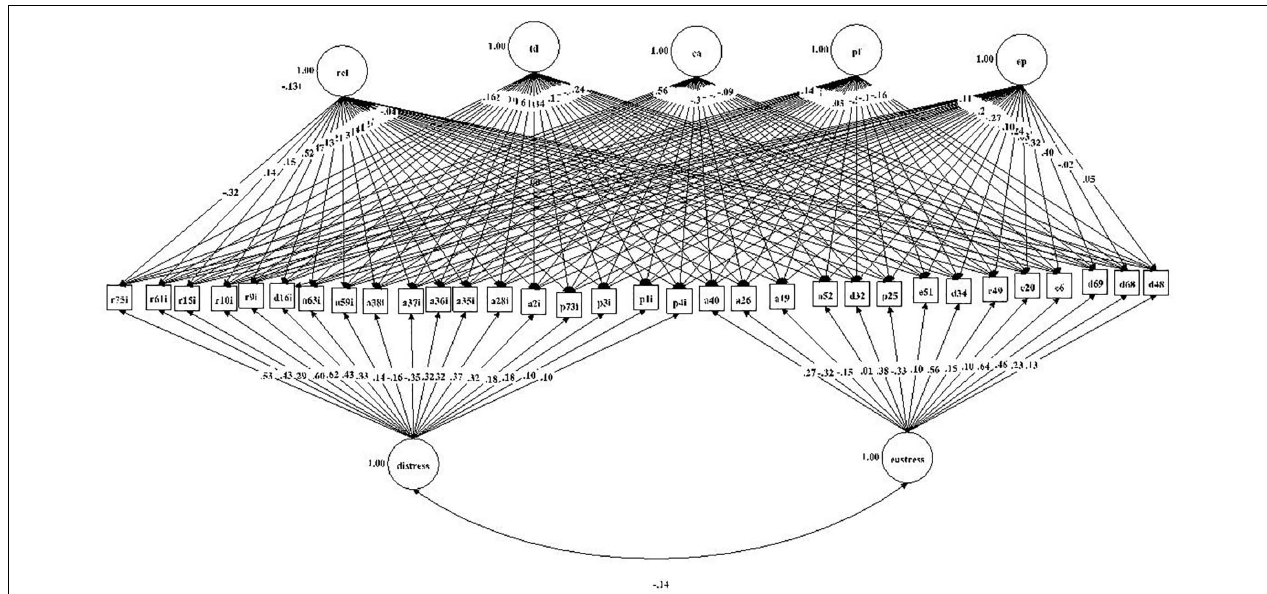
FIGURE 5 | Path diagrams of model. Bifactor solution including global factors (eustress and distress) and specific factors (rel, ac, td, pf, and ep). Note that path diagram figures are only intended to be illustrative as providing detailed labels would make the diagrams too large to